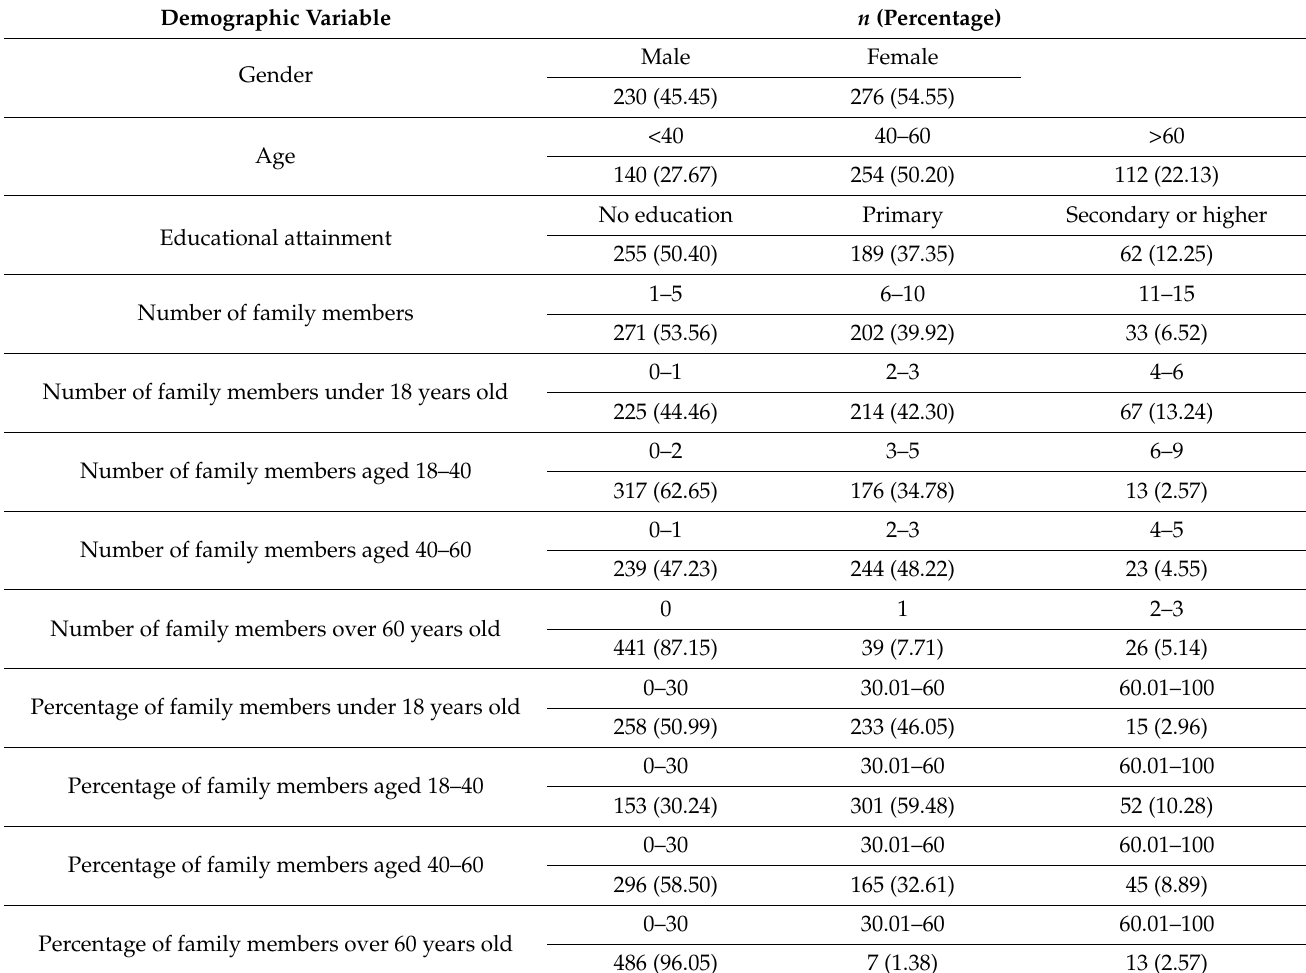
Table 3. Descriptive statistics of demographic variables ( n =